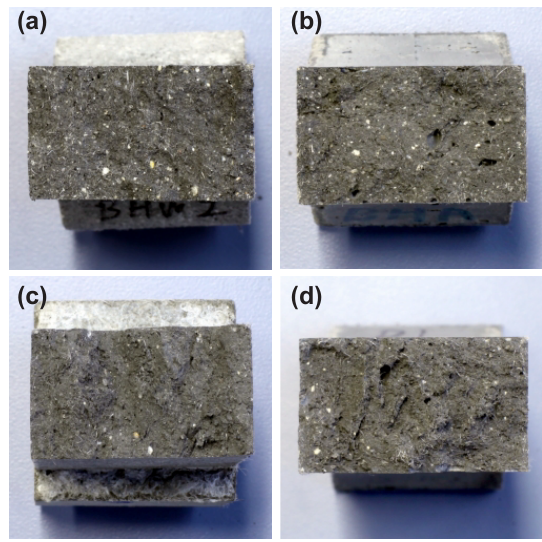
Figure 13. Fracture surfaces after failure of specimens in uniaxial tension tests: ( a ) B-print; ( b ) B-cast; ( c ) C-print; and ( d )